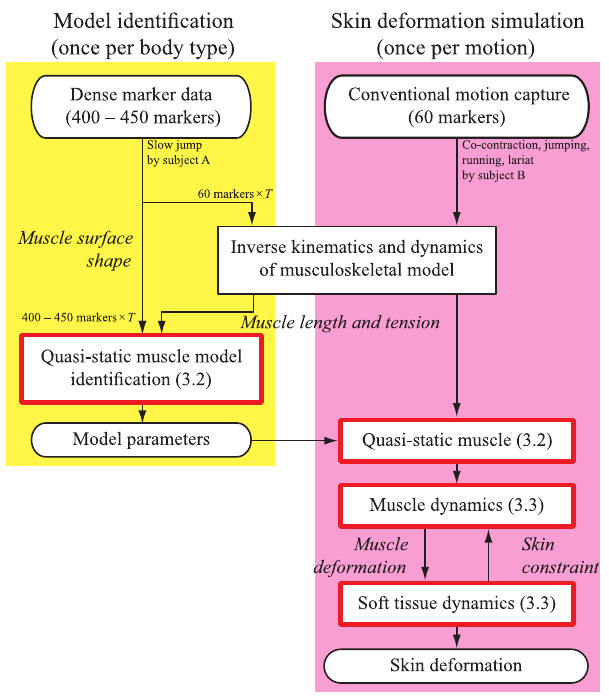
Fig. 2 Block diagram of the identification and simulation processes. The red borders depict the new components developed in this work. The identified model parameters are used in the simulation of motion sequences.